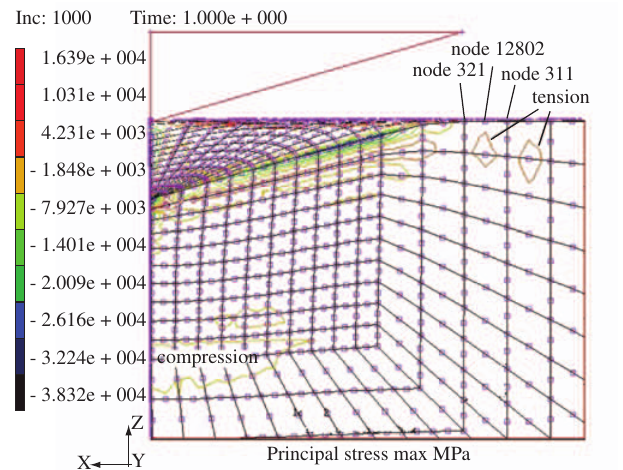
Figure 5. Distribution of the highest principal stress in the plane that contains the indentation diagonal.